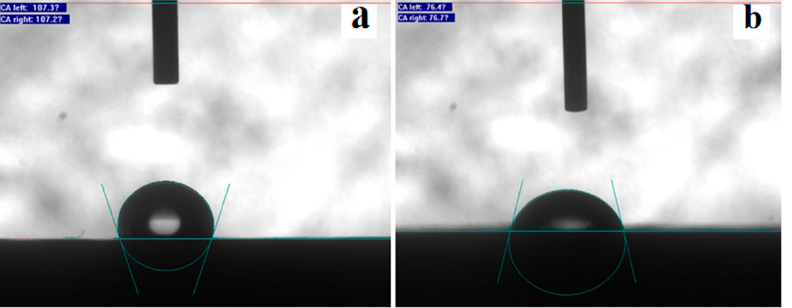
Figure 8. Contact angles of ( a ) water and ( b ) GO–Pyr nanocomposite on the surface of paraffin film.